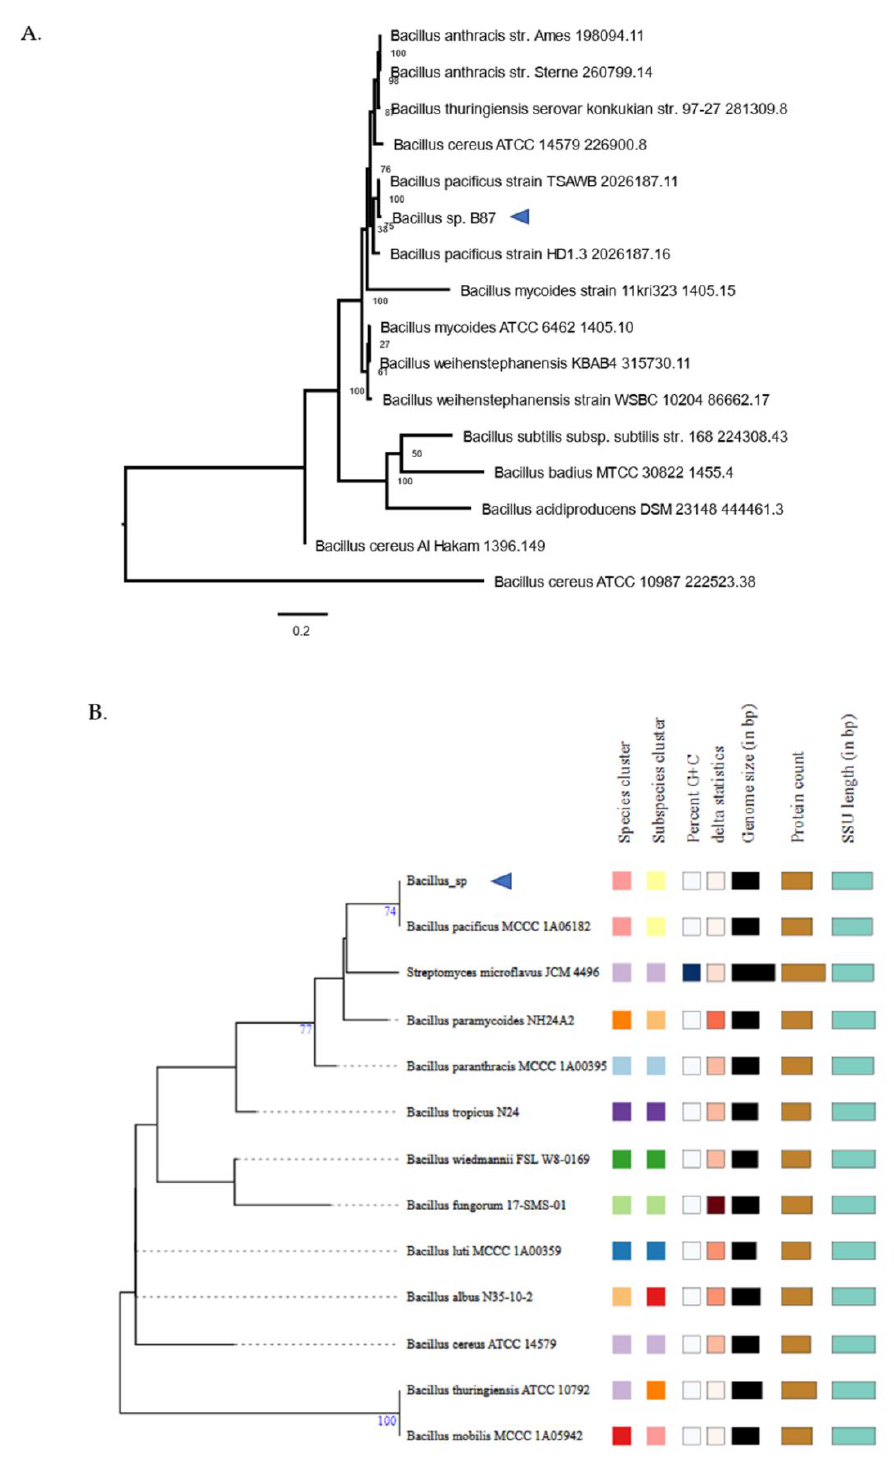
gene (Figure 4B) and whole-genome (Figure 4C) phylogeny reconstructions using TYGS confirmed a close association of Bacillus sp. B87 with B. pacificus .